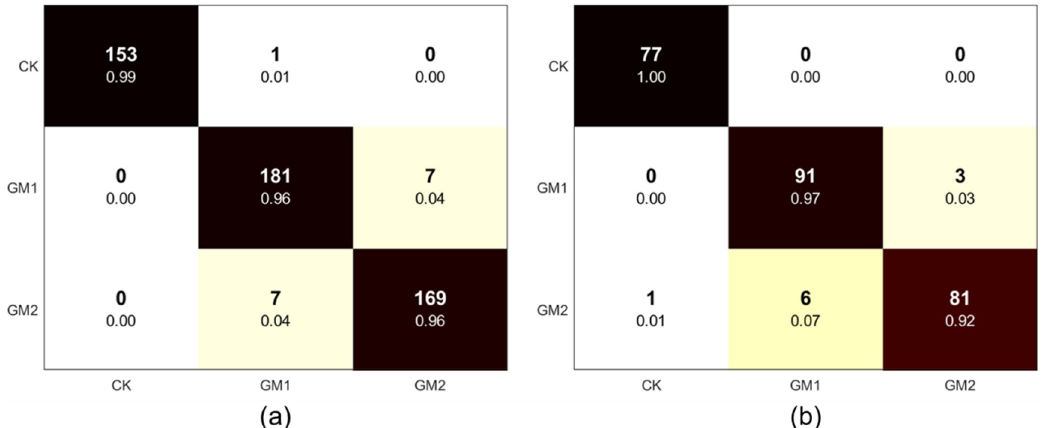
Figure 7. Transformation from the original average spectra ( a ) to 2D matrices ( b ). Table 3. Performance of VGG net models established by 2D spectral matrices.